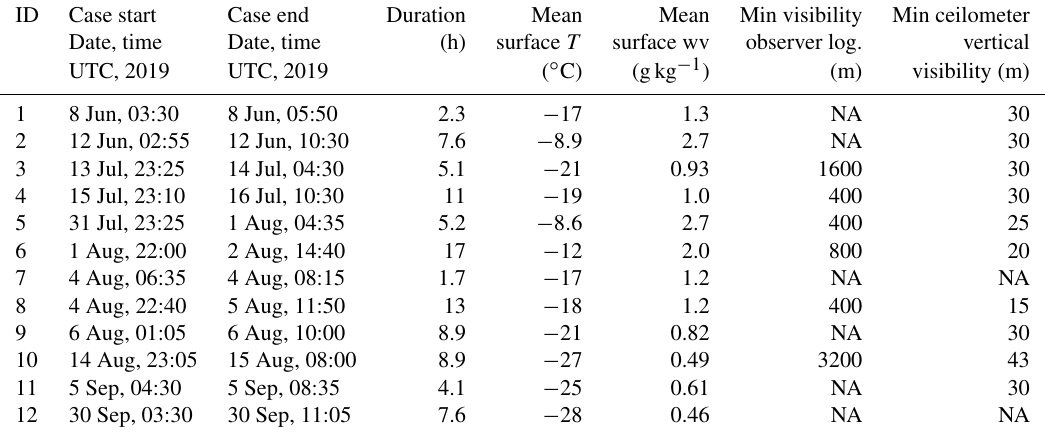
Table 3. Details of the 12 radiation fog cases used in this study, including mean temperatures ( T ) and water vapour mixing ratios (wv). Note that the minimum visibility comes from observer reports at 00:00, 12:00, and 18:00UTC and may not represent the minimum visibility outside of these times. Values where data were not available are indicated by NA – for example, when the observer did not log a visibility within the fog time frame or when the ceilometer did not report an obscured vertical visibility. Local time is UTC −